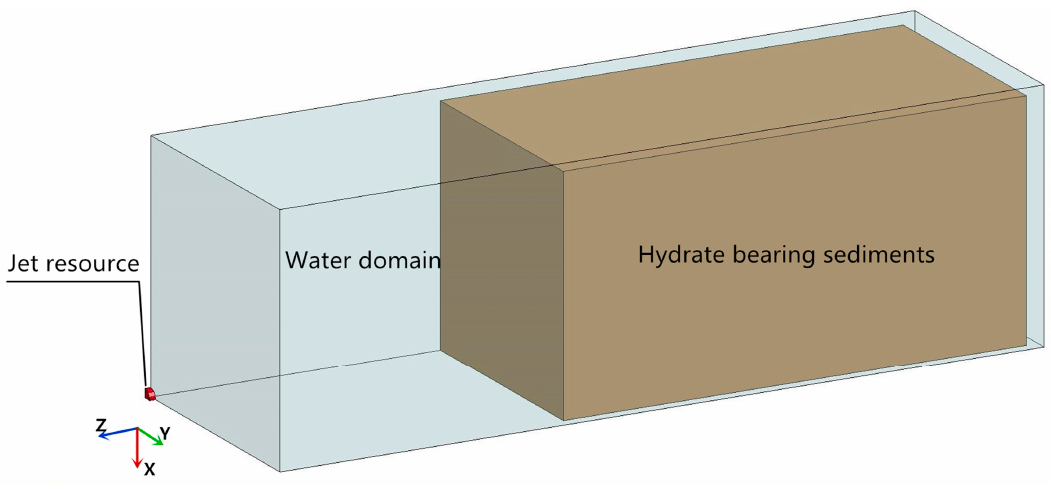
Figure 3. A quarter geometric model of HBS erosion by a submerged water jet.